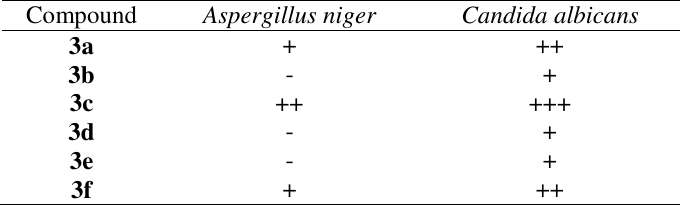
Table 2. Inhibitory effect of the compound ( 3a-f